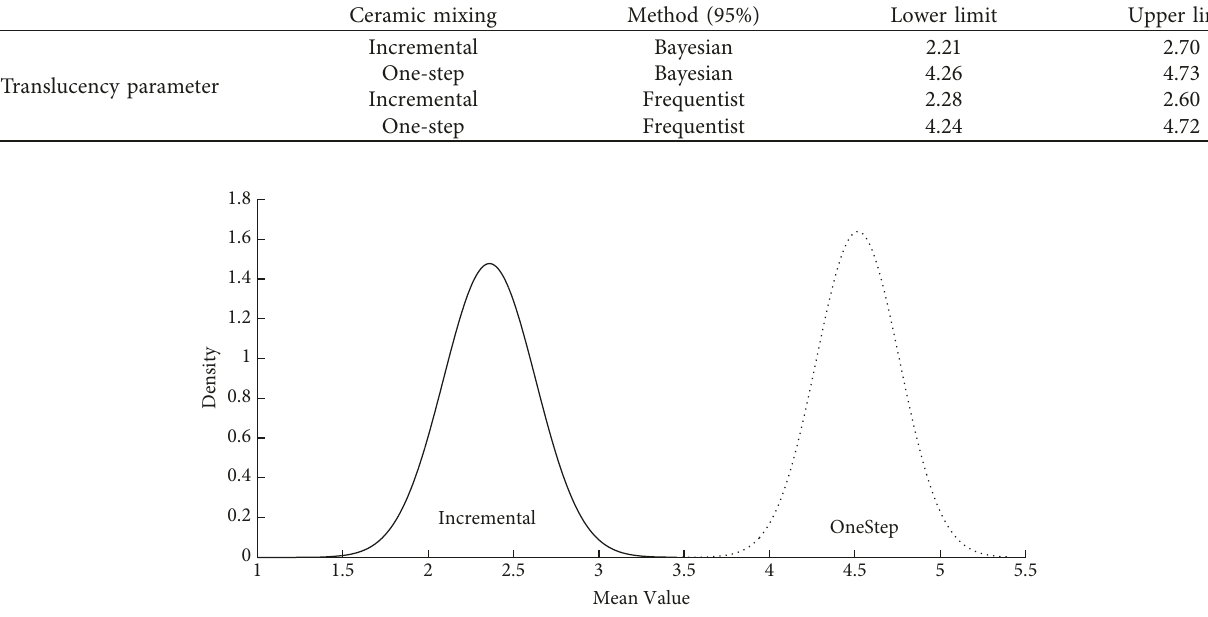
i ) for incremental (A μ 1 )